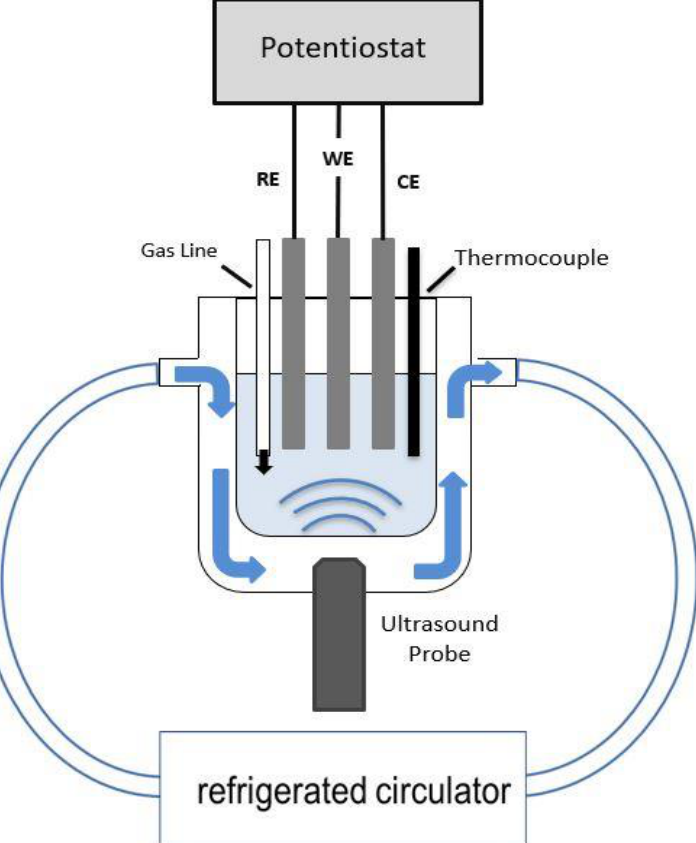
Figure 2. Schematic diagram of a sonoelectrochemical reactor experimental set-up. CE, counter electrode; WE, working electrode; and RE, reference electrode.